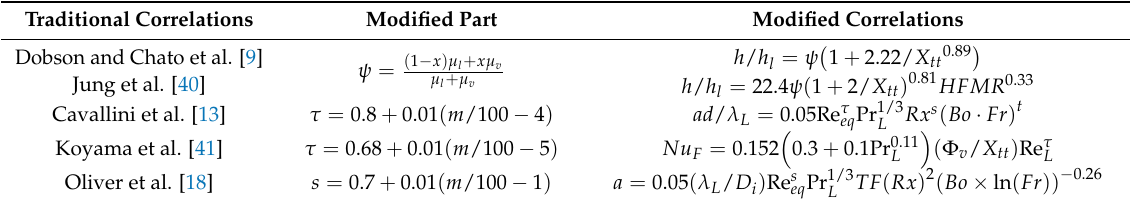
Table 6. Modification of